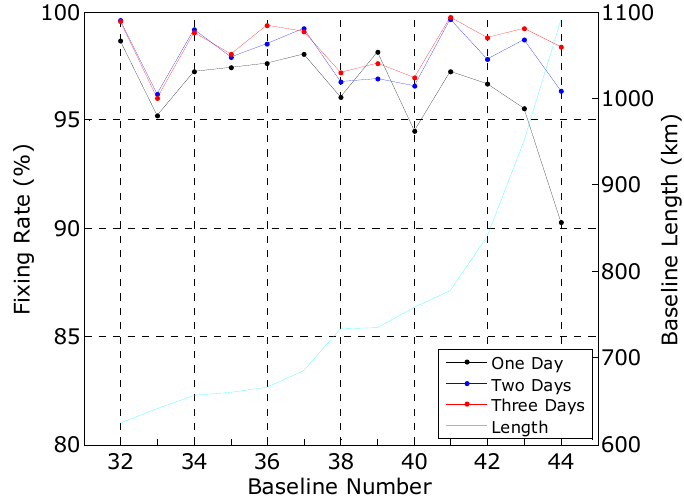
Figure 9. Improvements in the fixing percentage when using the proposed method with multi-day observation data.